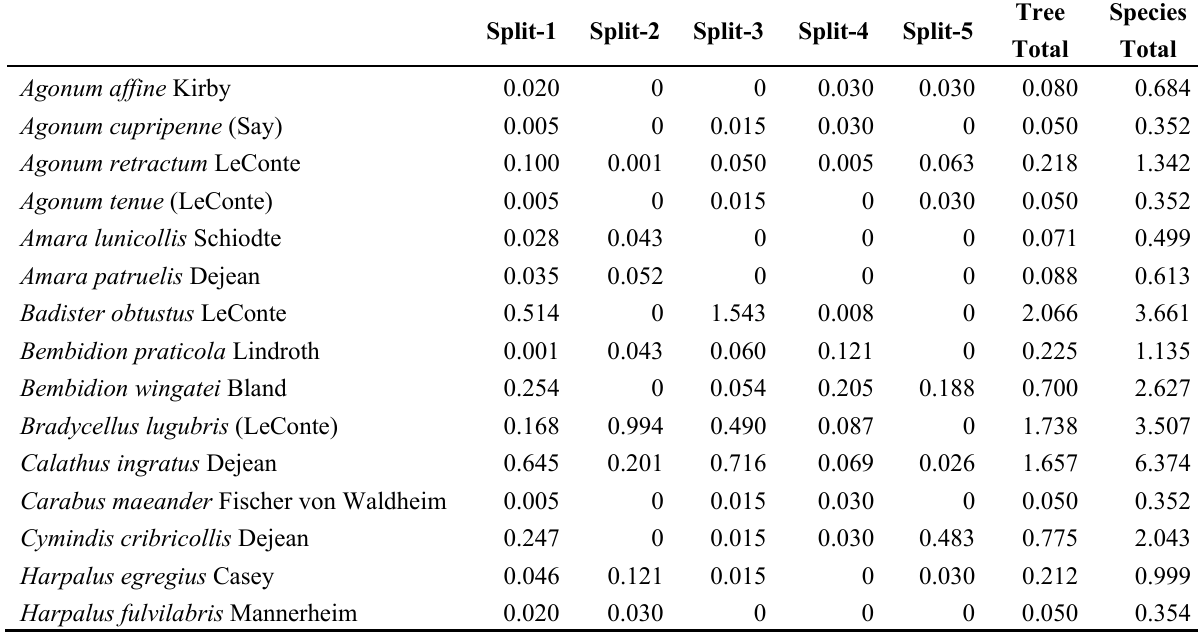
Table 3. Individual species variances by split within the ssMRT, total tree variance and total variance explained for the multivariate regression